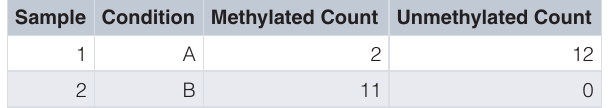
Table 1. A very small example data